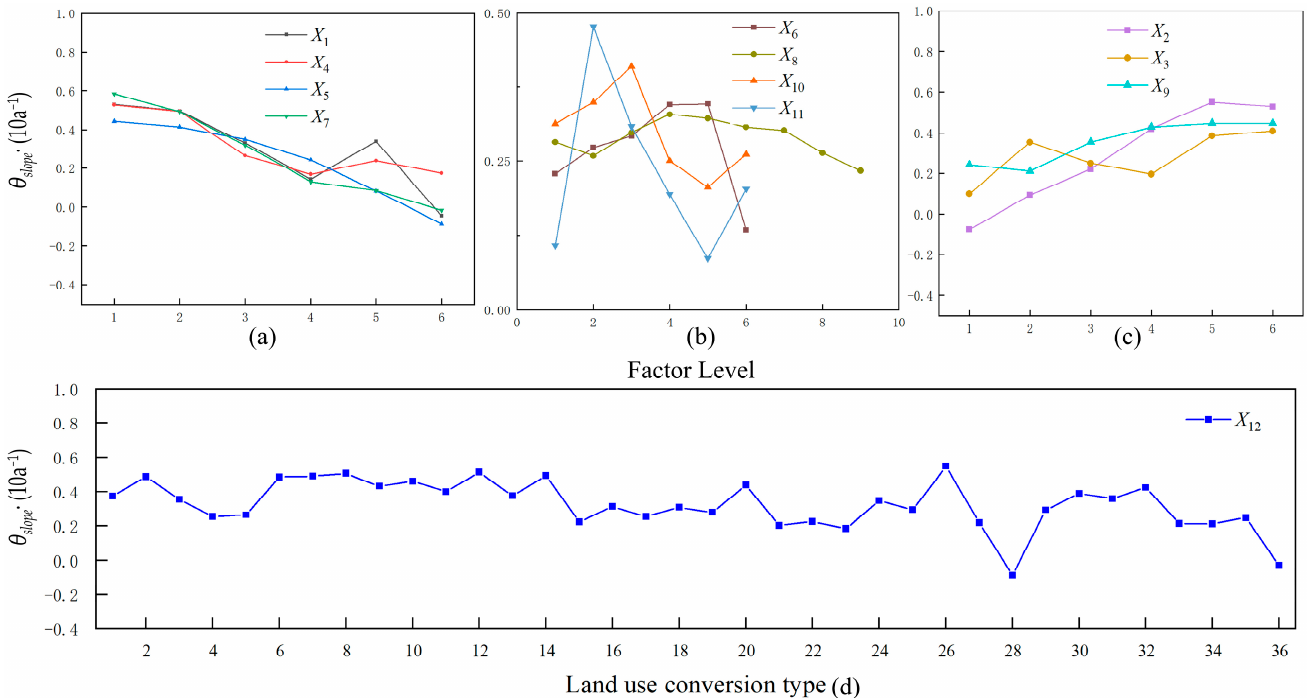
Figure 5. SPEI’s variation trend with the influence of ( a ) MAT ( X 1 ), MSD ( X 4 ), DTR ( X 5 ), Elevation ( X 7 ); ( b ) DTC ( X 6 ), Aspect ( X 8 ), AOPD ( X 10 ), POS ( X 11 ); ( c ) MP ( X 2 ), MWS ( X 3 ), Slope ( X 9 ); ( d ) LUCC ( X 12 ) with their levels. The meanings of the land cover and land use codes for land use conversion types can be found in Figure 2l. Table 5. Influence of the interacting pairs of factors. q = A ∩